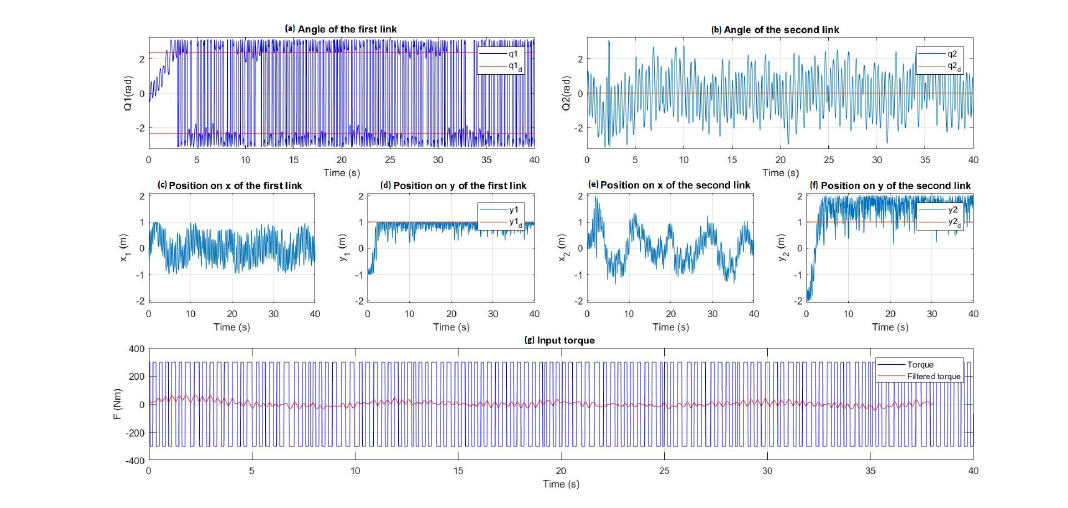
Figure 5. Results of the pulse-width modulation (PWM) controller to solve the acrobot problem. In the first row, he positions of the angle of the first ( a ) and the second ( b ) links are shown in radians. The red line in ( a ) is the moment when the balancing controller starts to control for the balancing problem. The red line in ( b ) is the desired angle of the second link. In the second row, there are the positions on x ( c ) and y ( d ) of the first link and on x ( e ) and y ( f ) of the second link. The red lines in ( d ) and ( f ) are the goal height (1 m) of the swing-up problem. In the last row, the graph ( g ) shows in blue the applied torque of the motor, and in red the same torque after a low-pass filter (the average of 10 values). By this method, it is possible to see the effect of the PWM, changing the frequency of the input signal.